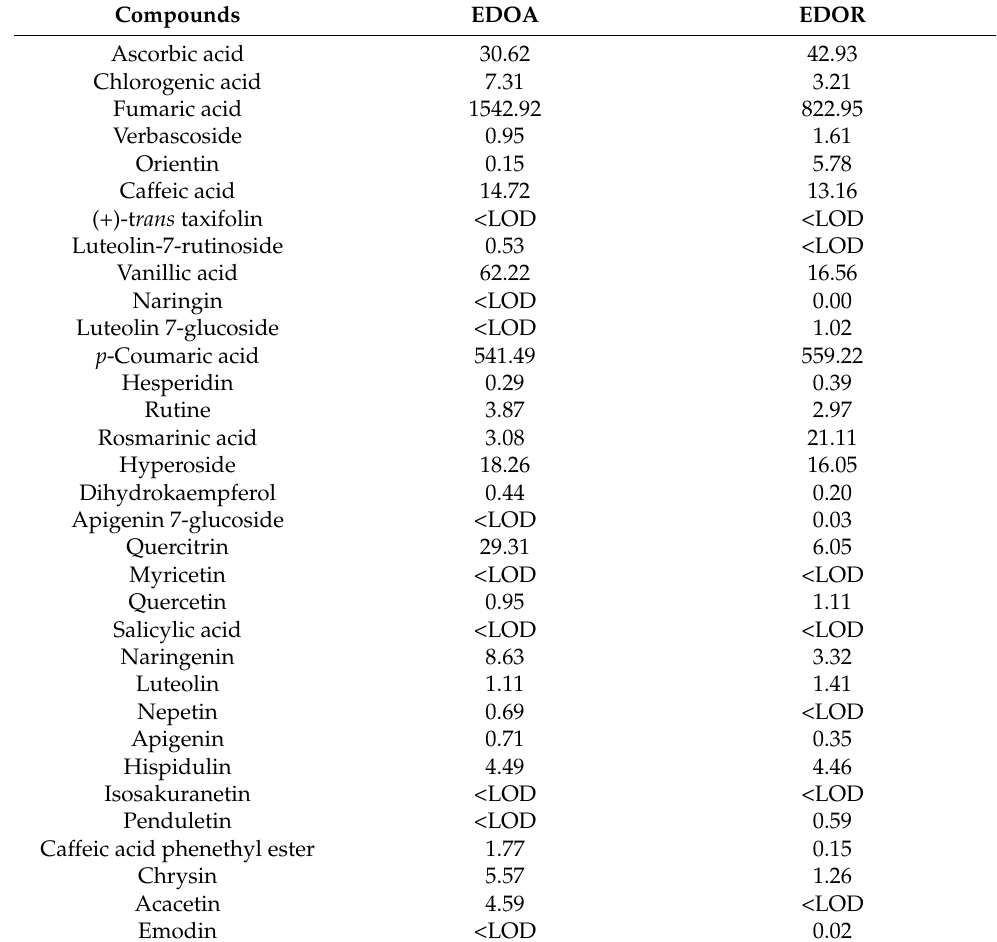
Table 4. The quantity of phenolics (mg/kg extract) in ethanol extract of D. osmanica aerial parts (EDOA) and roots (EDOR) determined by LC-HRMS.